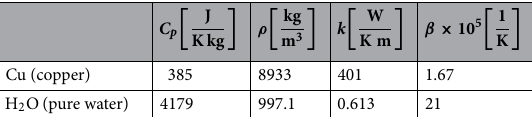
Table 2. Thermophysical properties of water and copper.